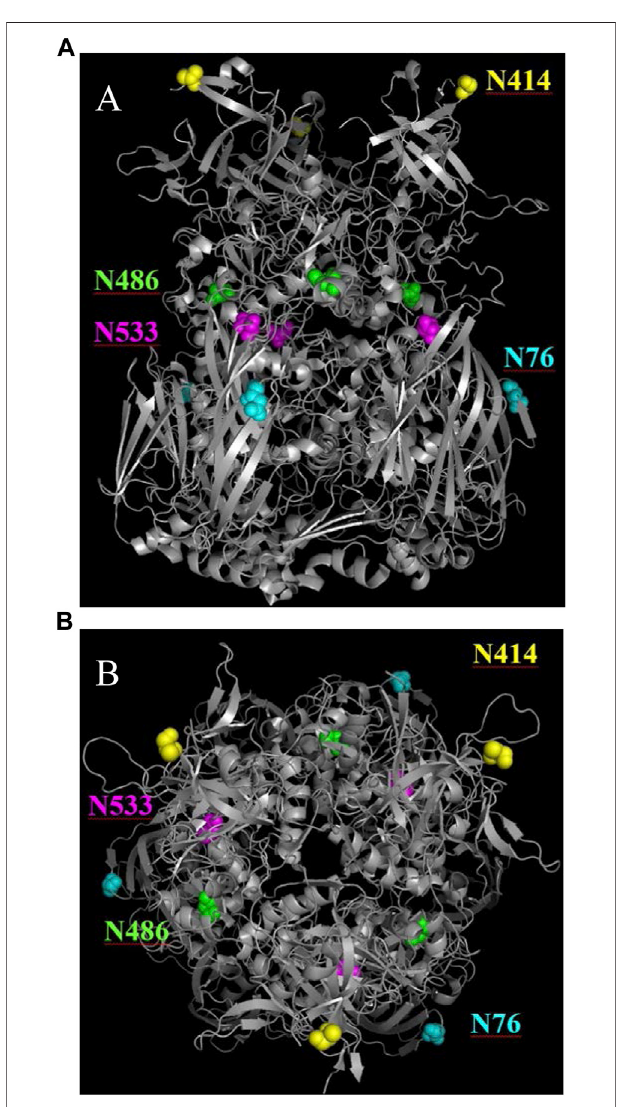
FIGURE 6 | Ribbon diagrams of the hexon AdC68 crystal structure (2obe.pdb) with selected asparagine residues highlighted. (A) demonstrates that N414 is on the surface and N76 is buried within the trimer. (B) demonstrates that N486 and N533 are buried within the hexon.